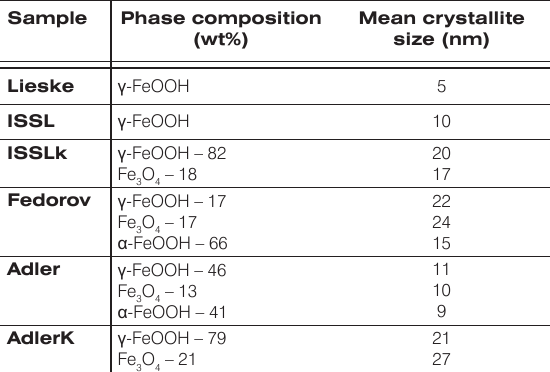
(F ig. 8) include two types of components: - components without hyperfine magnetic structure that appears like quadrupole doublets (Db); - components characterized by hyperfine magnetic structure, i.e ., sextets (Sx ).